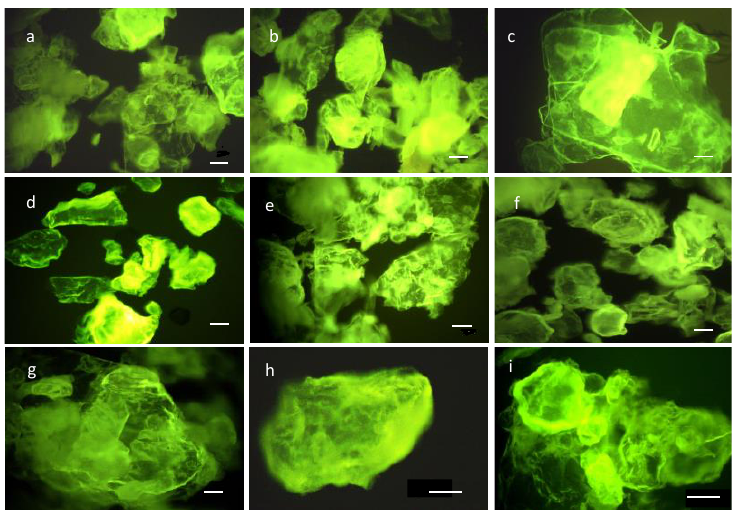
Figure 5. Epifluorescence images of chitosan powder prepared from 1 – 9 parameters (Table 5) ( a – g ) × 100; ( h , i ) × 200 magnification, scale bar = 100 µ